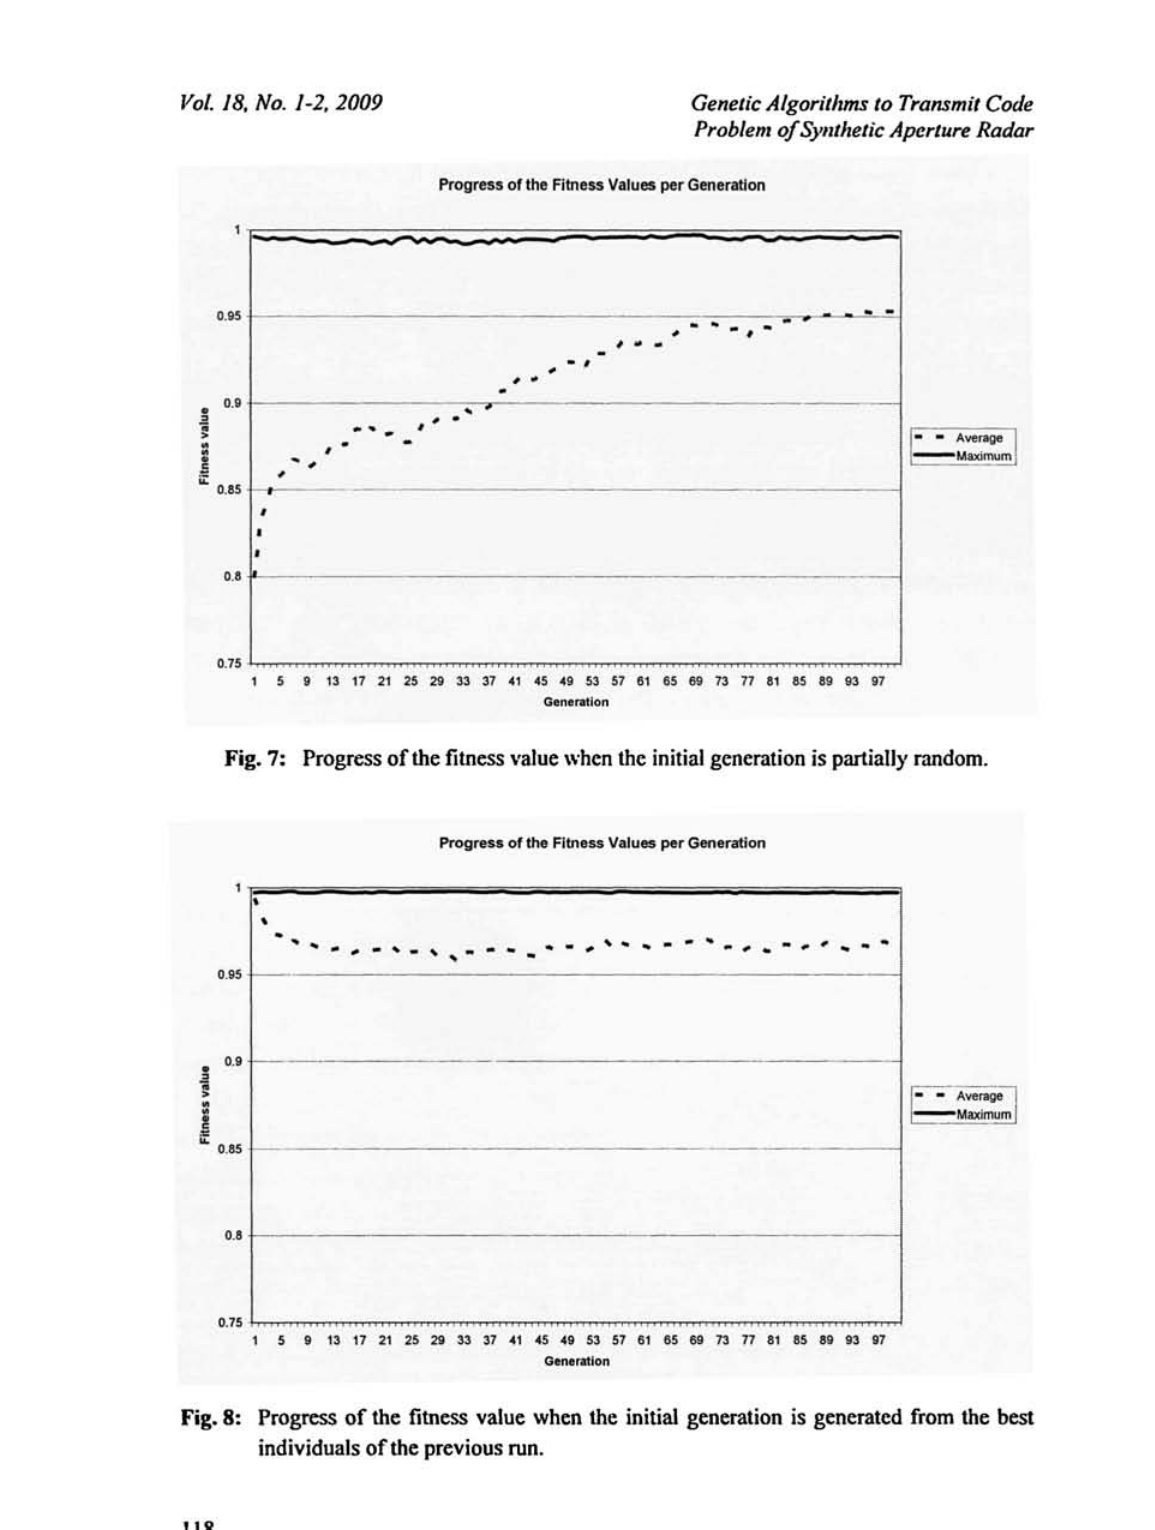
Fig. 8: Progress of the fitness value when the initial generation is generated from the best individuals of the previous